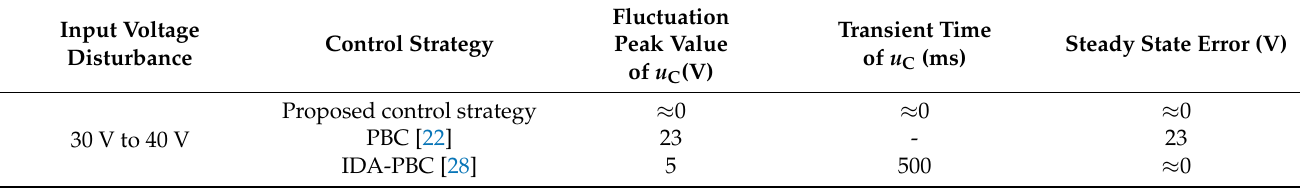
Table 4. Experimental results for u C of DDBC under different control strategies and input voltage disturbances. Input Voltage Disturbance